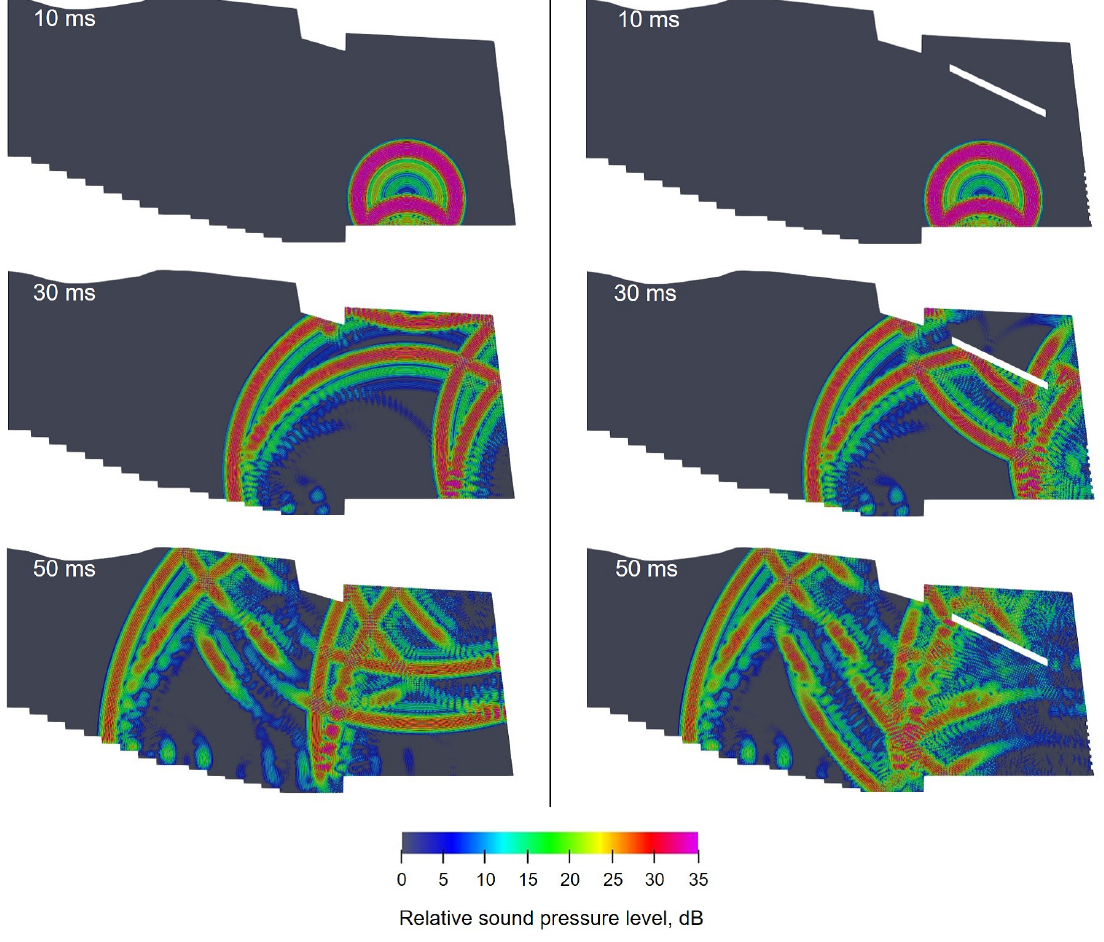
Figure 16. Sound propagation in a concert hall model for Cond. 1 (left column) and Cond. 2 (right column) at t = 10, 30 and 50